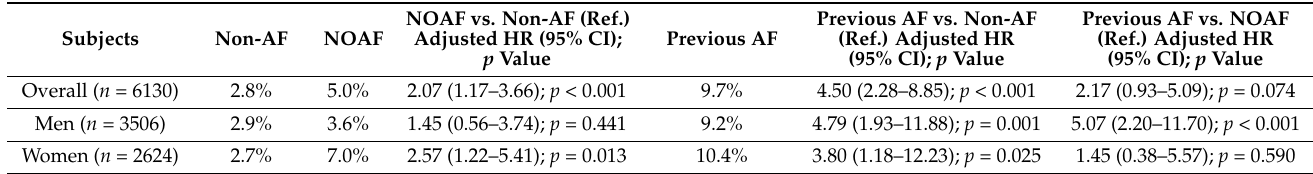
Table 3. Risk for ischemic stroke in patients with CHA 2 DS 2 -VASc score ≥ 2 according to AF